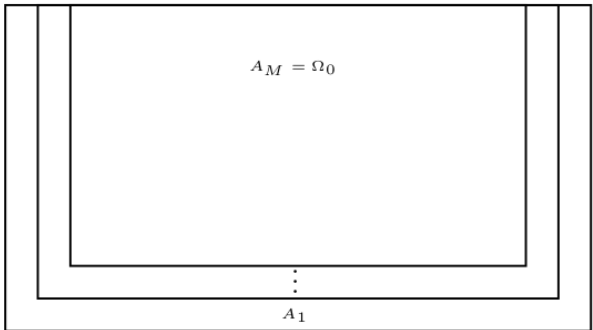
Figure 3. Nesting of domains for the hybrid ABC method. The full region A 1 is equivalent to (cid:127)